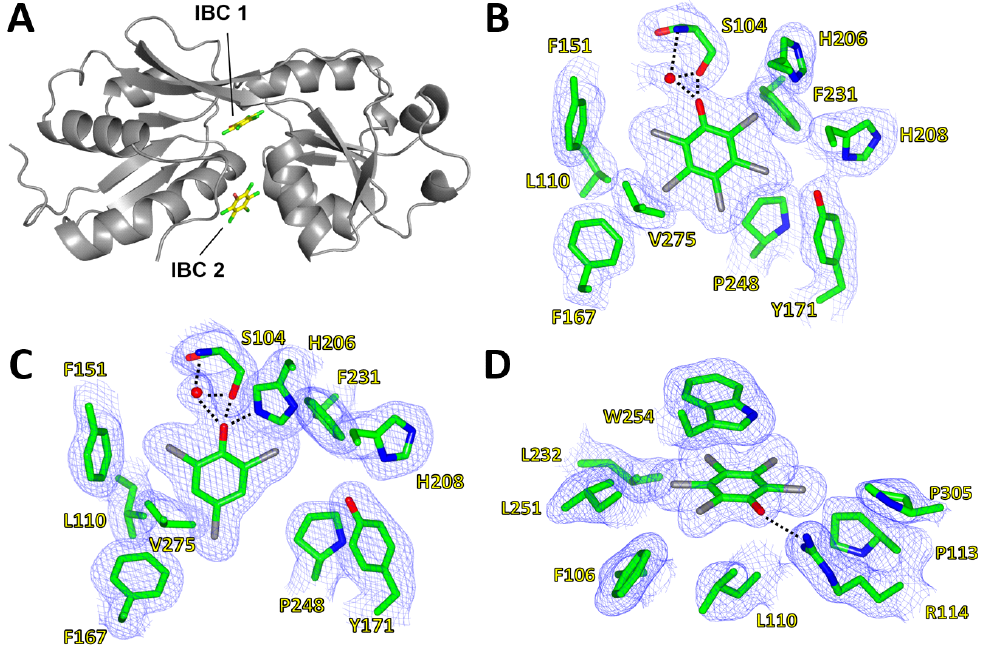
Figure 4. Inducer-binding cavities (IBC) of PcpR. ( A ) Relative locations of IBC1 and IBC2; ( B ) PCP binding cavity 1. 2F o –F c map showing coverage of PCP in IBC1 under the hinge between RDI and RDII; ( C ) 2,4,6-TCP binding cavity. 2F o –F c map showing coverage